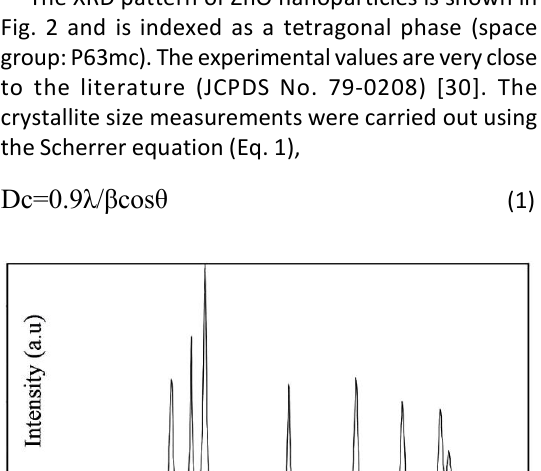
Fig. 4. SEM image of ZnO